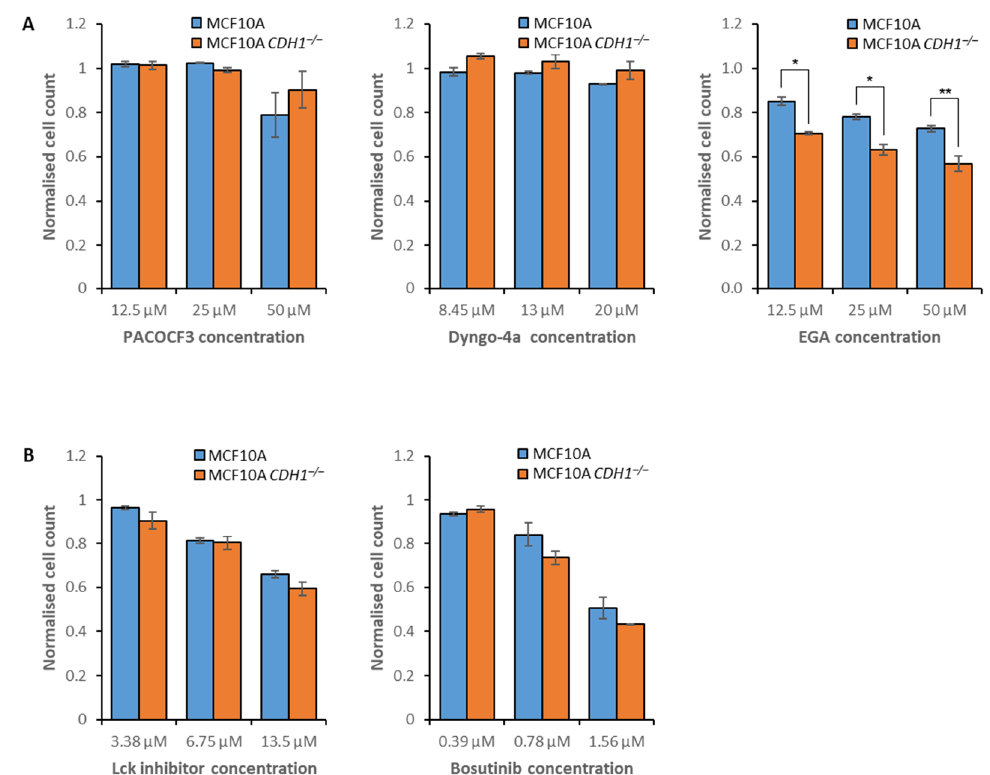
Figure 3. Efficacy of compounds inhibiting endocytosis and Src family kinases. MCF10A and MCF10A CDH1 − / − cells were drugged, then viability was quantified through nuclei counting, and normalization to vehicle controls. Although a nine-point serial dilution was assessed, only the three consecutive compound concentrations that exhibited the greatest difference in viability between CDH1 +/+ and CDH1 − / − cells are depicted. Where no toxicity was observed, the maximum assessed concentrations are depicted. ( A ) Cell viability following treatment with three endocytosis inhibitors. ( B ) Cell viability following treatment with inhibitors of Src family kinases. Average values were calculated from three biological replicates, with +/− 1 standard error of the mean depicted by error bars. P -values were calculated using Student’s t -test; * p < 0.05, ** p < 0.01.